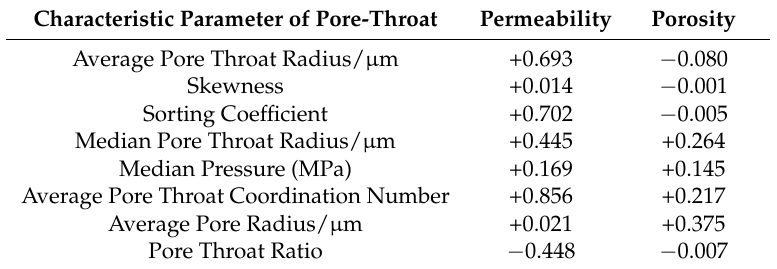
Table 2. Relation coefficient between different parameters of pore throat and porosity and